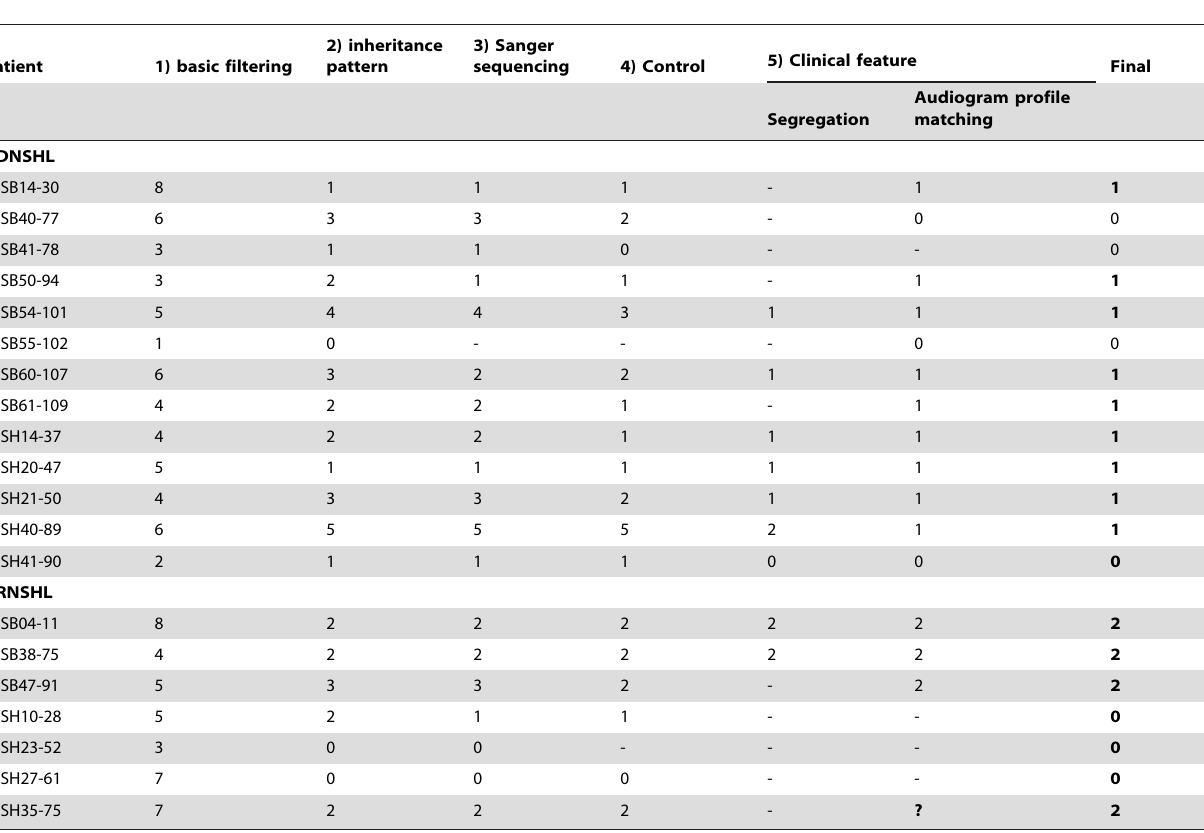
Table 2. Number of candidate SNVs in 20 familial NSHL through five filtering steps.